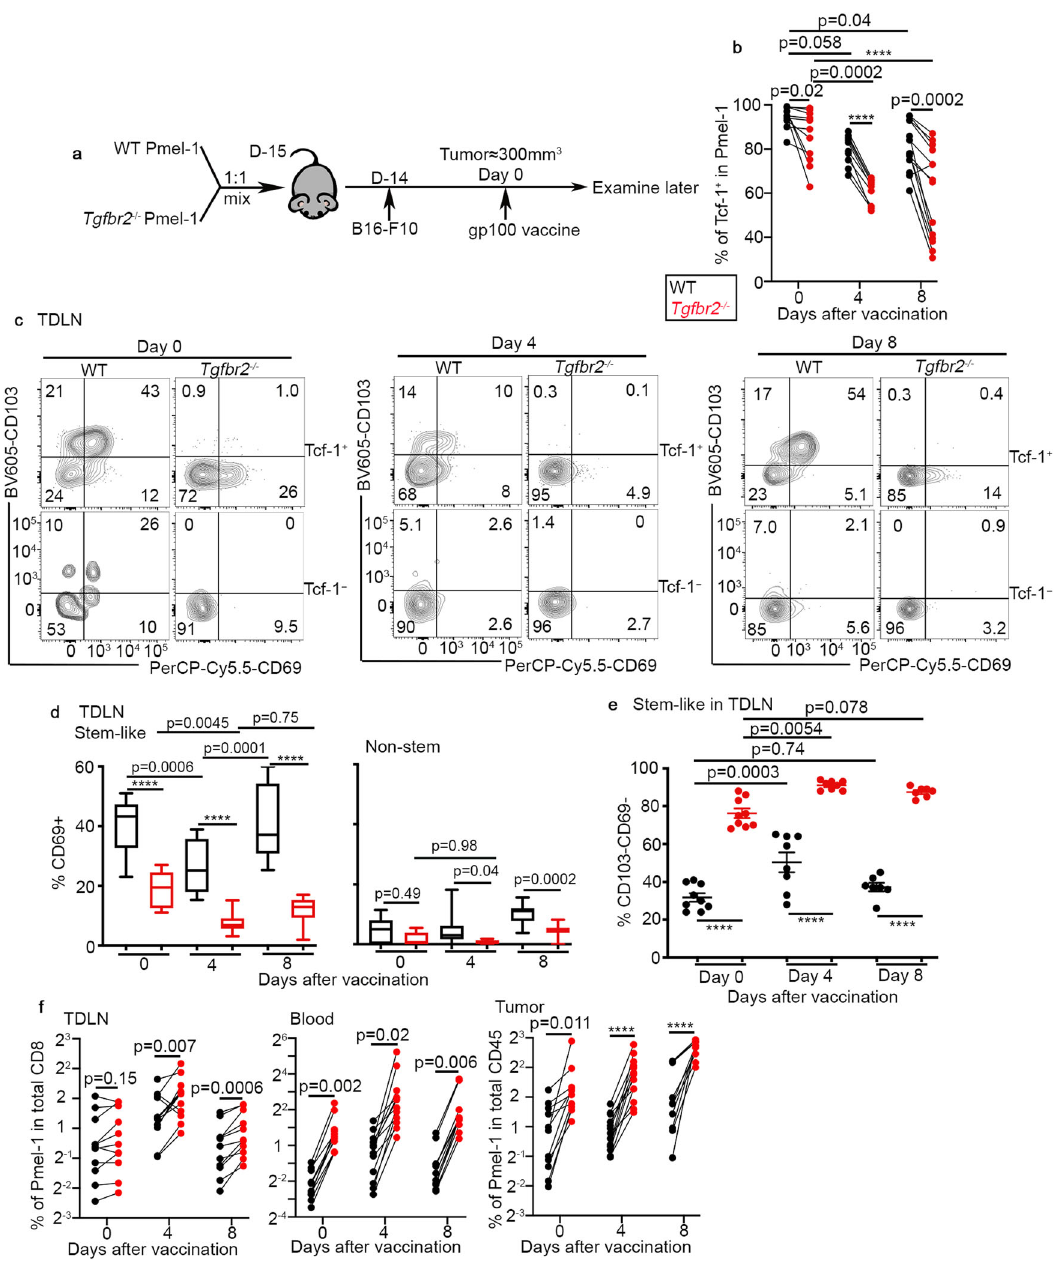
Fig.7|TumorvaccineinducesthelossoftissueresidencyinTDLNforstem-like T cells, accompanied by further differentiation into migratory effectors. a Experimental design. Black, WT and red, Tgfbr2 − / − . b The percentage of Tcf-1 + stem-likesubsetinTDLNPmel-1Tcellsatdifferenttimepointspostvaccinationare shown(d0, n =12/each,d4, n =10/eachandd8, n =14/each). c RepresentativeFACS pro fi les of pre-gated Tcf-1 + (Upper, stem-like) and Tcf-1 - (Lower, non-stem) Pmel-1 T cells in TDLN at different time points after vaccination are shown. d The per- centage of CD69 + cells in stem-like (Left) and non-stem (Right) Pmel-1 T cells iso- lated from TDLN are shown (For stem-like, d0 and d4, n =13/each, d8, WT, n =11 and Tgfbr2 − / − , n =13;fornon-stem,d0, n =9/each,d4, n =13/each,d8,WT, n =9and Tgfbr2 − / − , n =13). e The percentage of non-T RM (CD69 - CD103 - ) cells in stem-like